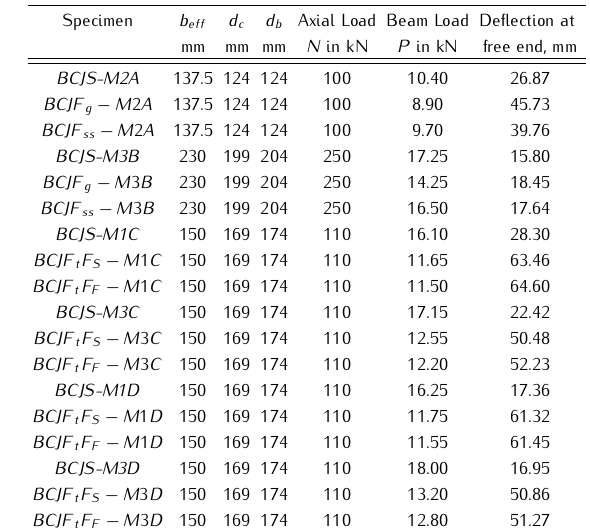
Table 4. Experimental data.